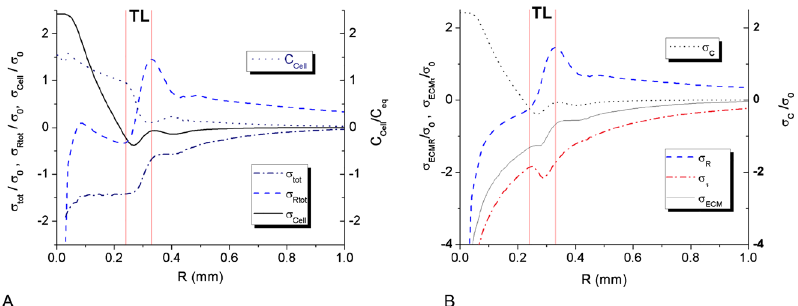
Figure 7: Stress distribution along MTS radius at day 5. (A) The total stress distribution σ tot / σ 0 is calculated within iso-strain model;thegraphalso showsradial componentof the totalstress σ Rtot / σ 0 , thestress conditioned bycells interaction σ Cell / σ 0 and concentrationofcells C cell / C eq , σ 0 =100Ps;(B)distributionofECMstress σ ECM / σ 0 ,tangentialcomponentof ECMstress σ τ / σ 0 and its radial component σ R / σ 0